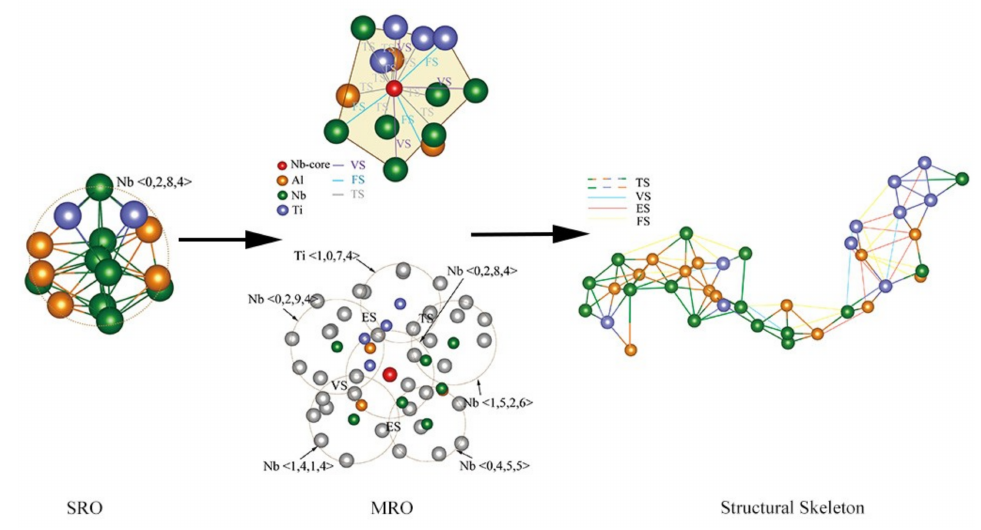
Figure 11. The variation of atomic volume as Al concentration increasing in (TiNb 3 ) 1 − x Al x alloys.